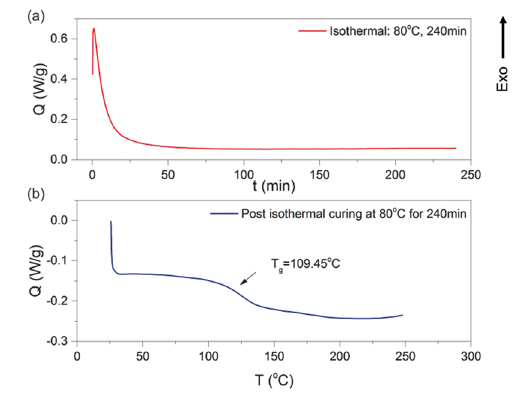
Figure 6. DSC results for the epoxy system Araldite ® LY5052/ Aradur5052 TM sample of 1.50mg: (a) isothermal cure at 80°C during 240min and (b) second run dynamic for cure verification.